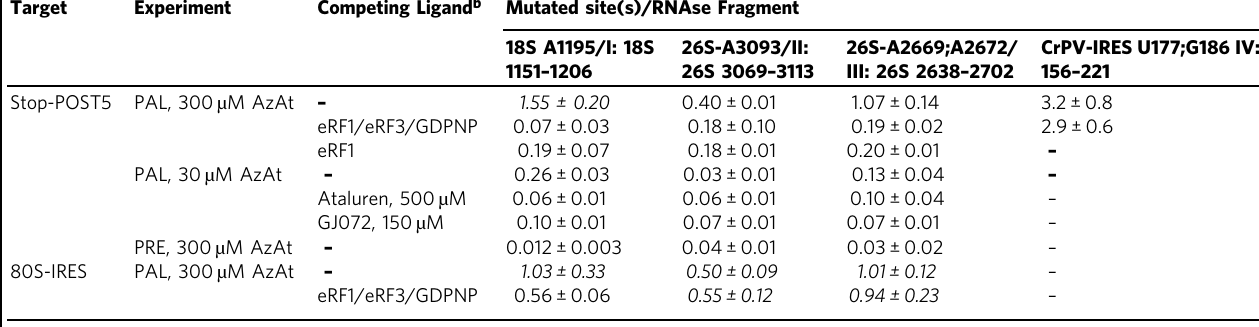
Table 1 Photoincorporation yields (mole%) into RNAse H Fragments a .